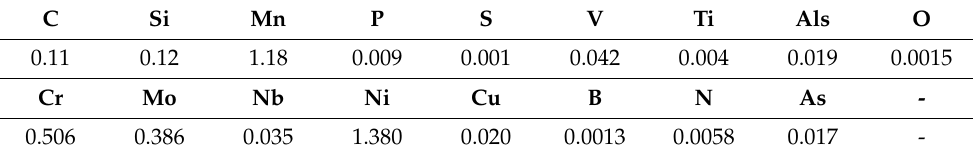
Table 1. The chemical composition of the tested steel (wt%).